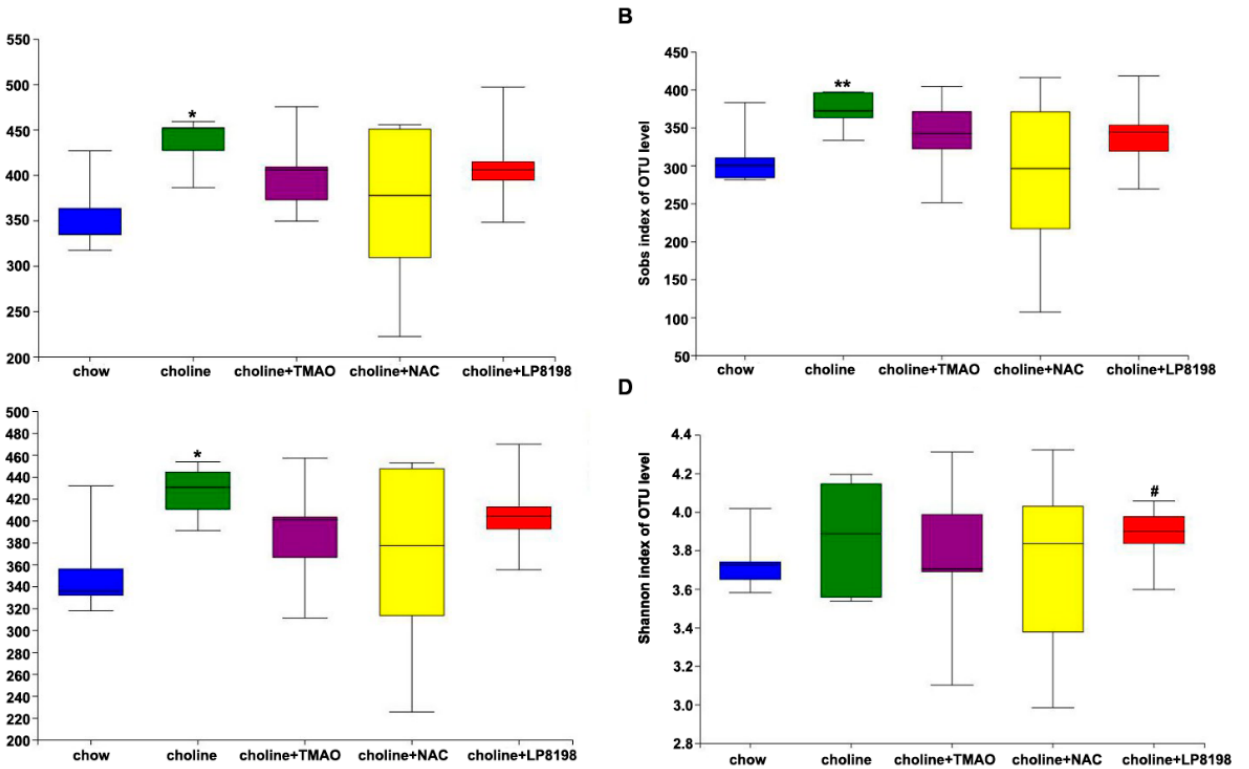
Figure 6. Alpha diversity of bacterial communities. Estimation of bacterial richness ( A – C ) and diversity ( D ) is visualized using boxplots for chow (blue), choline (green), choline+TMAO (purple), choline+NAC (yellow) and choline+LP8198 (red) groups. The boxplots show the median, quartile, smallest and largest observations. n = 5 per group, the Wilcoxon rank-sum test was performed to determine statistical significance of alpha diversity analyses. * p < 0.05; ** p < 0.01, vs. the chow group. # p < 0.05, vs. the choline group.